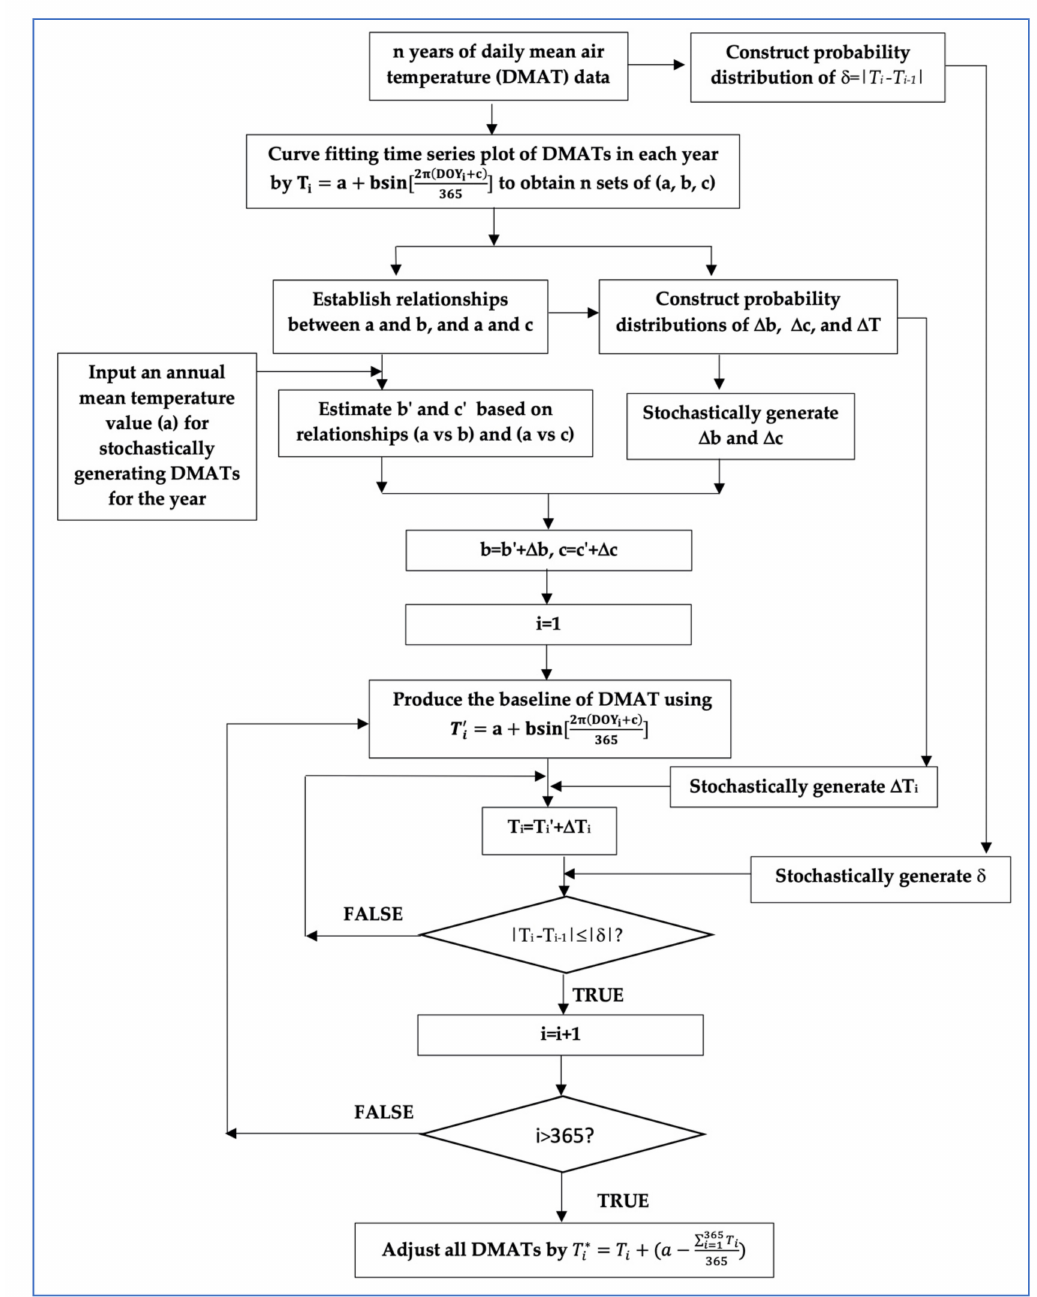
Figure 1. Flowchart of the CSWG for stochastically generating